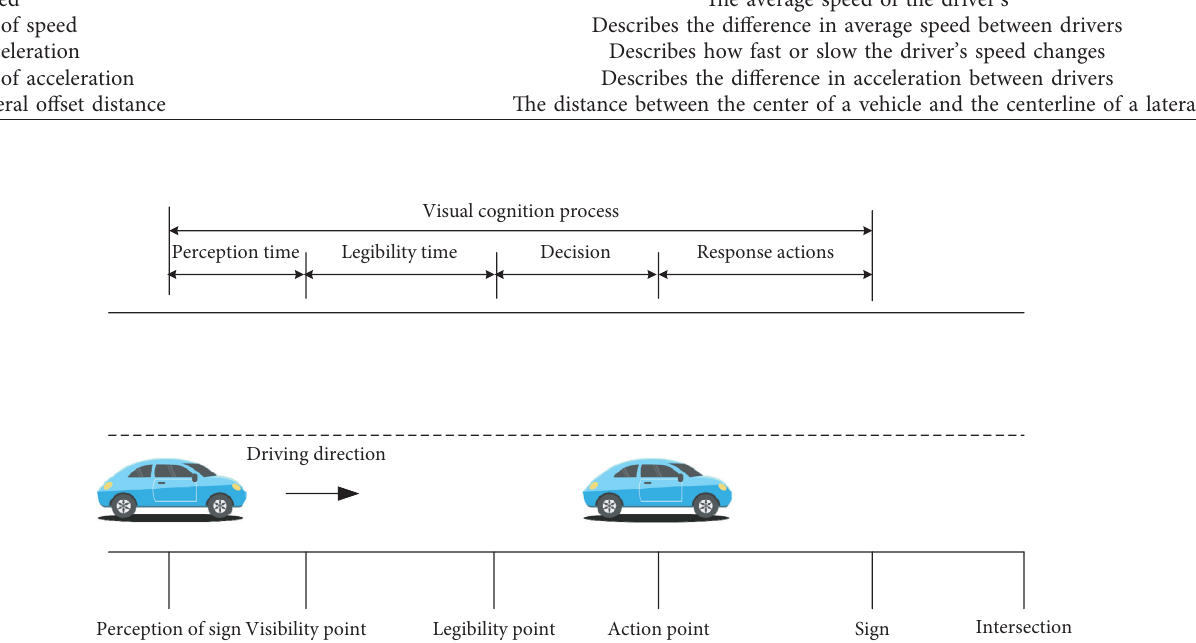
Figure 4: Illustration of the experimental